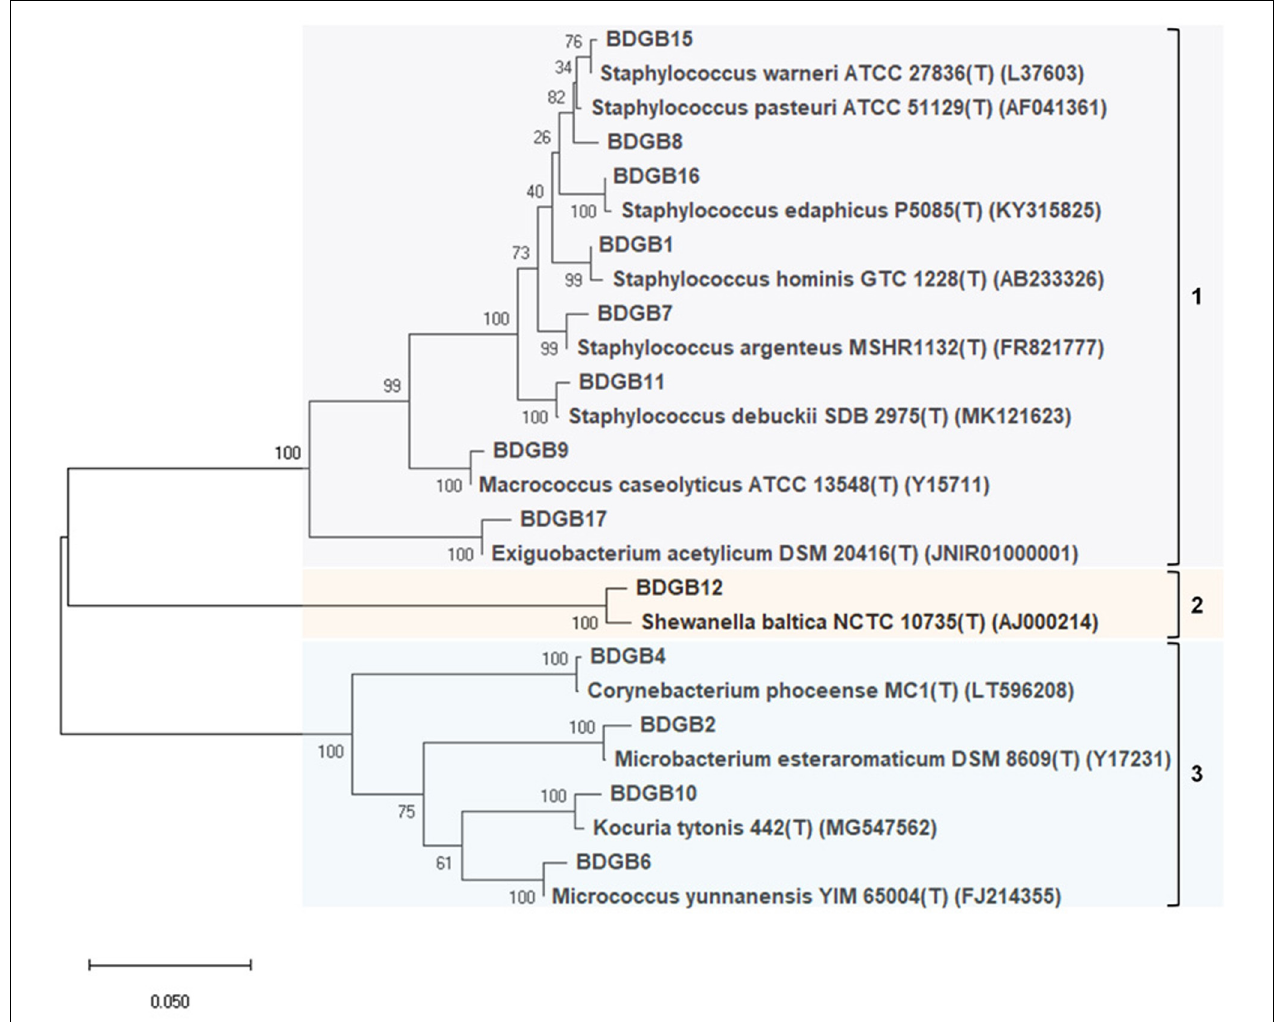
FIGURE 2 | Phylogenetic tree constructed based on partial 16S rRNA gene sequences indicating evolutionary relationship of the enzyme-producing isolates among themselves and with their nearest type strains. Sequences were aligned with MUSCLE or ClustalW algorithms and a maximum-likelihood tree of the alignment was constructed using the Tamura-Nei model. Bootstrap values (%), indicated at branches, were calculated from 1000 replicates. Accession numbers of the type strains are given in parentheses after the strain